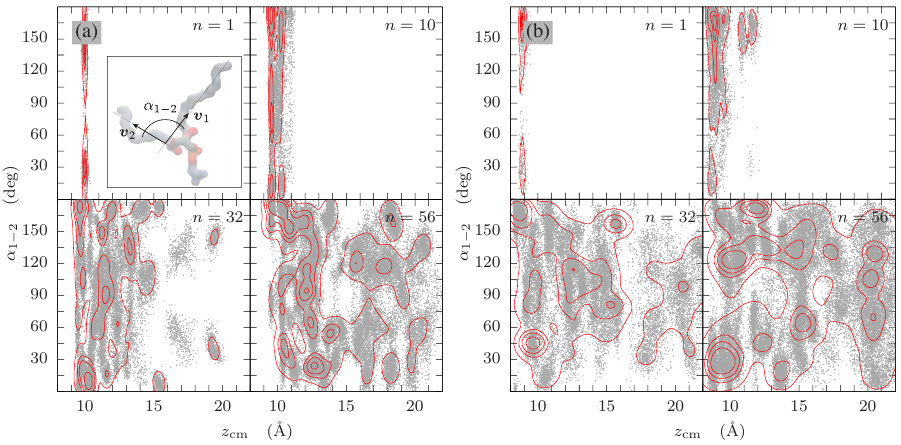
Figure 3. Internal tail-tail angle α 1 − 2 distribution with respect to the POPC center-of-mass distance z cm from the hydrophobic siloxane ( a ) and hydrophilic alumina ( b ) surface. The red contour lines correspond to 10, 25, 50 and 90% confidence intervals of the fitted 2-dimensional kernel densities, respectively.